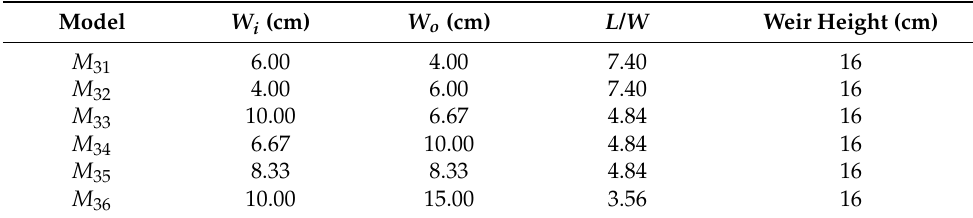
Table 5. Third set of dimensions for the six models.